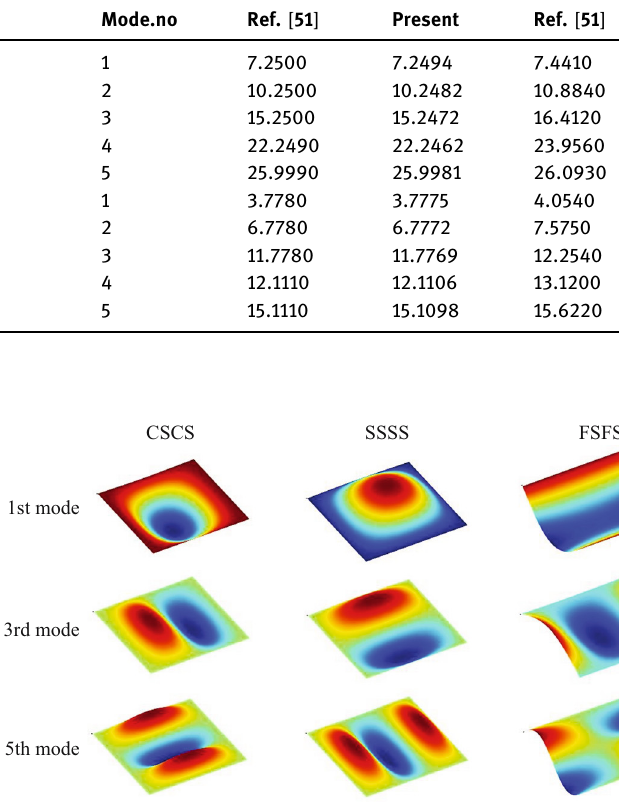
Table 2: Comparison of the natural frequency of present method and published literature Boundary conditions